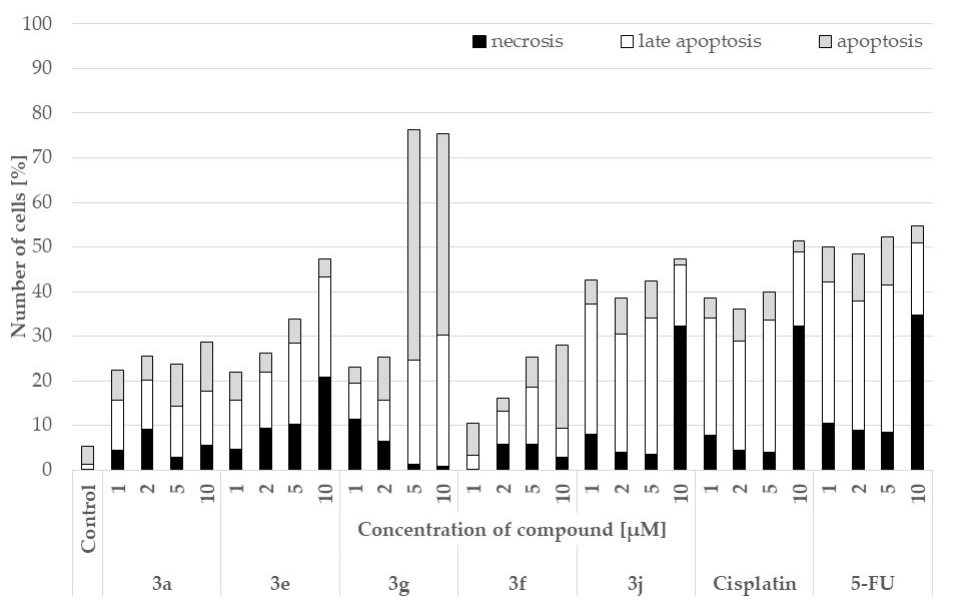
Figure 5. Apoptosis in cells treated with 1, 2, 5, and 10 µM concentrations of compounds 3a , 3e , 3f , 3g, and 3j for 24 h in comparison to cisplatin and 5-fluorouracil.